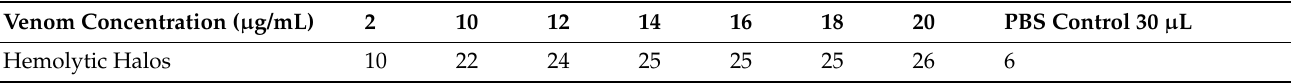
Table 7. The MHD of N. melanoleuca venom at various concentrations on human erythrocytes. Venom Concentration ( µ g/mL)